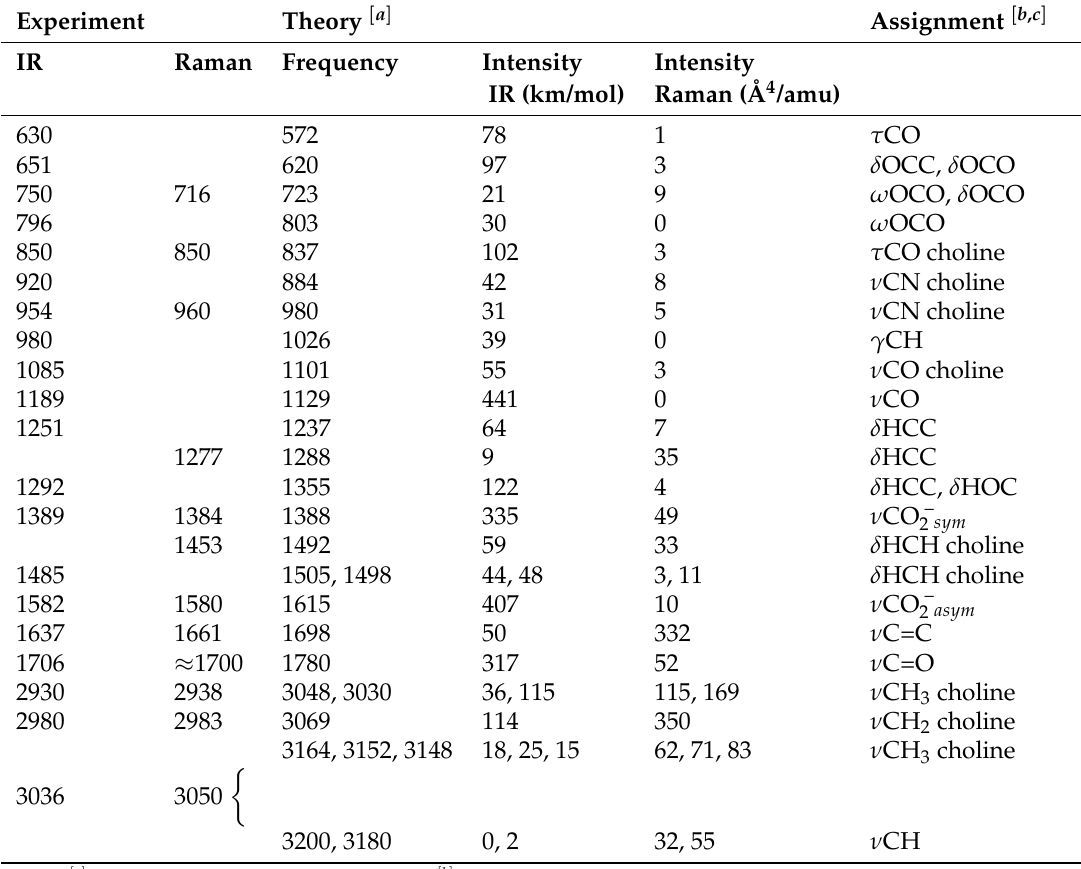
Table 1. Observed (IR and Raman) and calculated (B3LYP/6–311++G**) vibrational frequencies [cm − 1 ]